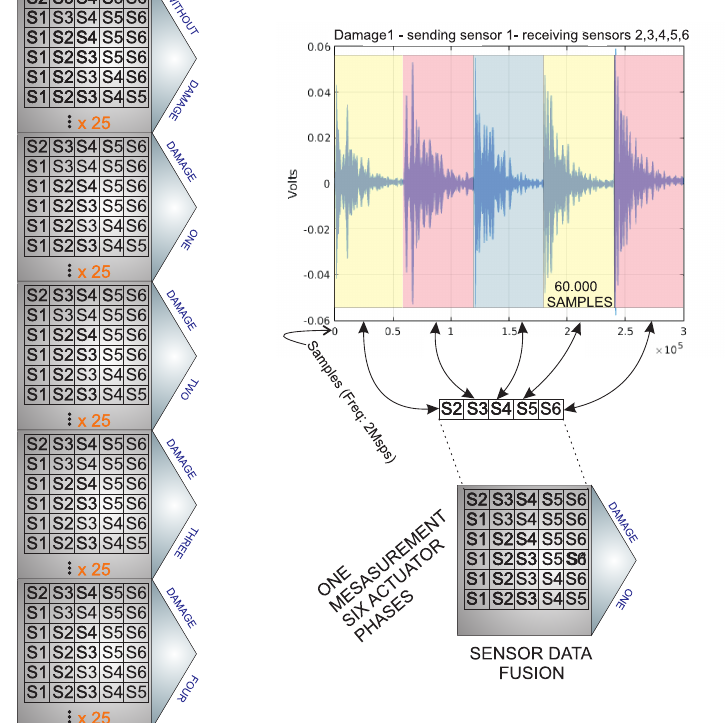
Figure 2. Data organization for sensor data fusion.